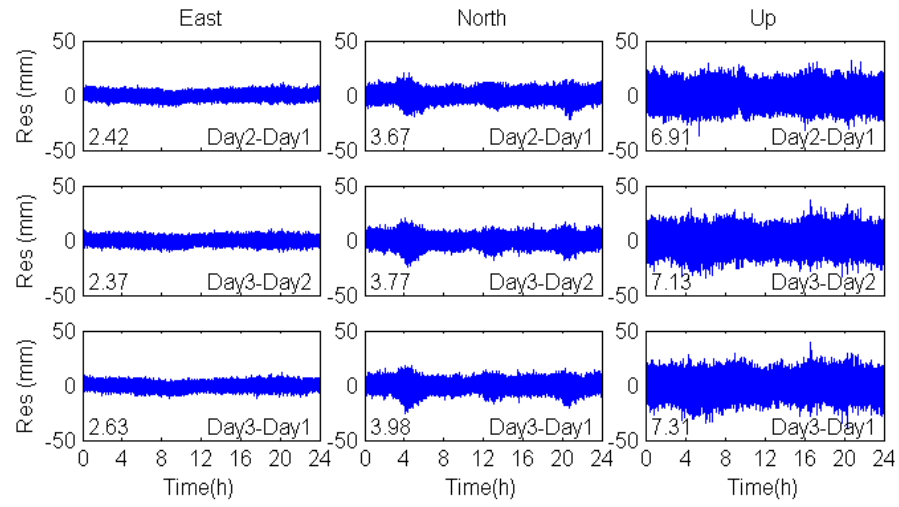
Figure 9. Sidereal filtering results in the observation domain for multipath errors in the east, north and vertical coordinate directions. Table 5. Correlation of the BDS multipath